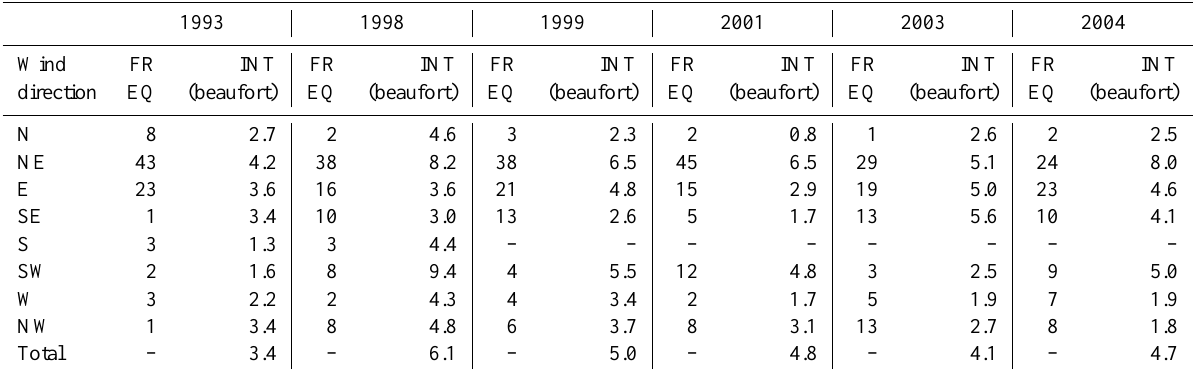
Figure 9. The two circulation patterns appearing in February: the anticyclonic (left) and the cyclonic (right). Table 3. Frequency (FREQ) and intensity (INT) of winds from various directions (N, NE, E, SE, SW, W, NW) in November in years with high (1993, 1998 and 1999) and low (2001, 2003 and 2004) evaporation rates. The frequency is a number of occurrences of specific wind direction within a month based on three-times-per-day sampling. Total indicates the monthly wind